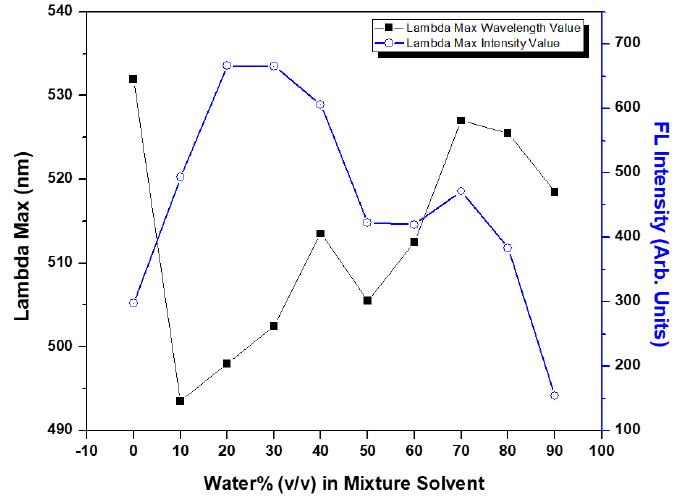
Figure 9. Fluorescence intensity and emission peak of polymer 1 as a function of water content in DMSO (1 μ M repeating units, λ ex at 339 nm).